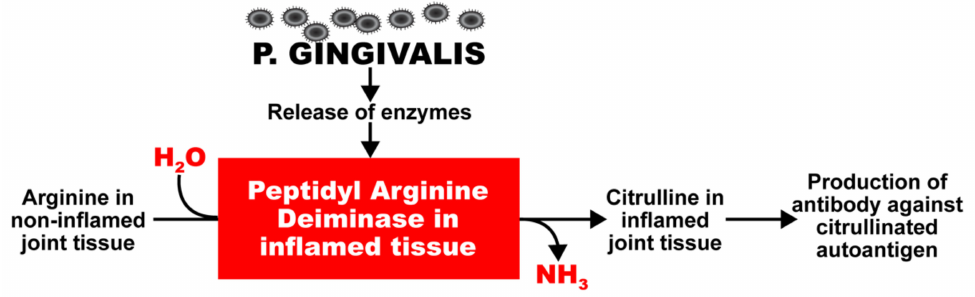
Figure 1. Potentiation by oral pathogens. Oral pathogens such as P. gingivalis can potentiate the deamination of arginine or formation of citrullinated proteins and peptides in joint and other